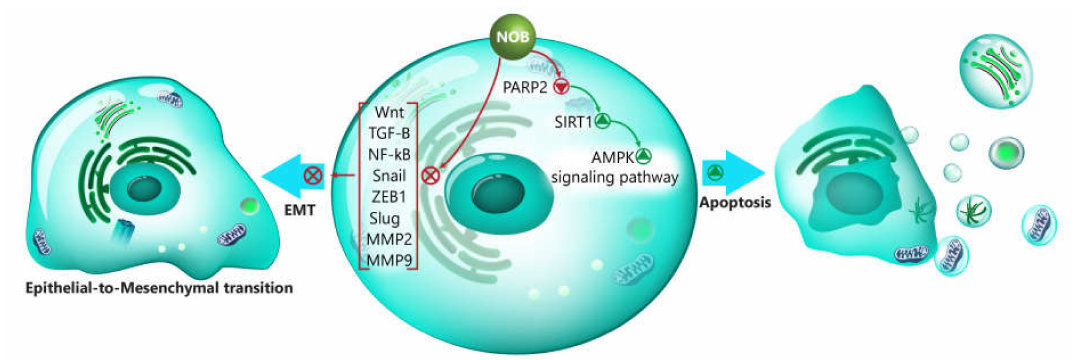
Figure 1. The involvement of signaling pathways in the regulation of EMT by NOB. AMPK, AMP-activated protein kinase; SIRT1, sirtuin 1; PARP2, poly (ADP-ribose) polymerase 2; NOB, nobiletin; Wnt, Wingless-related integration site; TGF- β , transforming growth factor- β ; NF- κ B, nuclear factor-kappa B; ZEB1, zinc finger E-box binding homeobox 1; MMP-2, matrix metalloproteinase-2; MMP-9, matrix metalloproteinase-9; and EMT, epithelial-to-mesenchymal